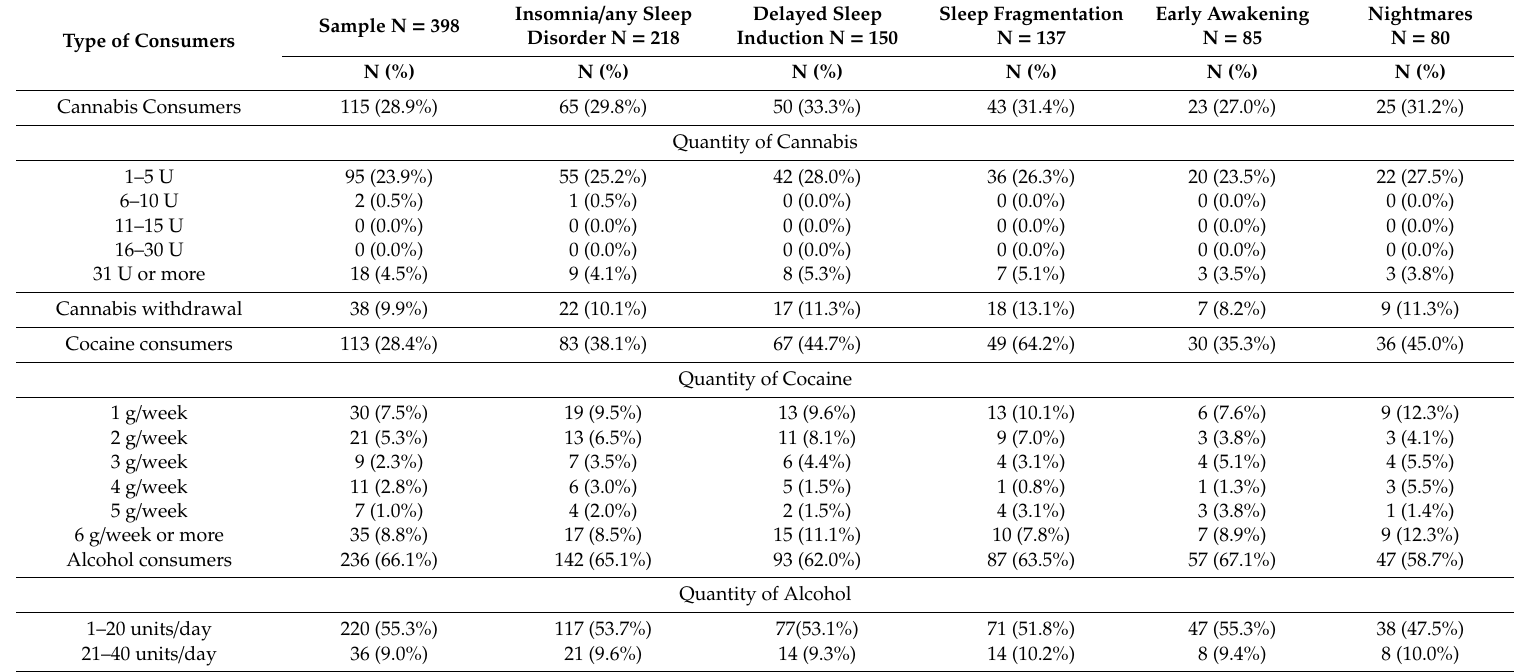
Table 2. Use and quantity of cannabis, cocaine, alcohol, opioids, and benzodiazepines consumed. Data for total sample and subgroups associated with sleep disorders appear in di ff erent columns. For alcohol and cannabis users there is an extra variable related with withdrawal. Abbreviations: CWA-Ar ≥ 10; Revised Clinical Institute Withdrawal Assessment for Alcohol Scale, upper 10